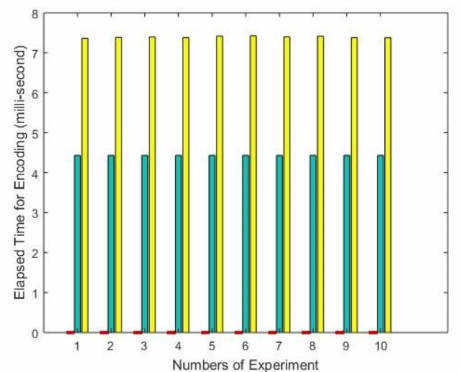
Figure 8. Elapsed time vs. number of experiments to compare encoding speeds when using RSA (green color), ECC (yellow color), and proposed algorithms (red color).